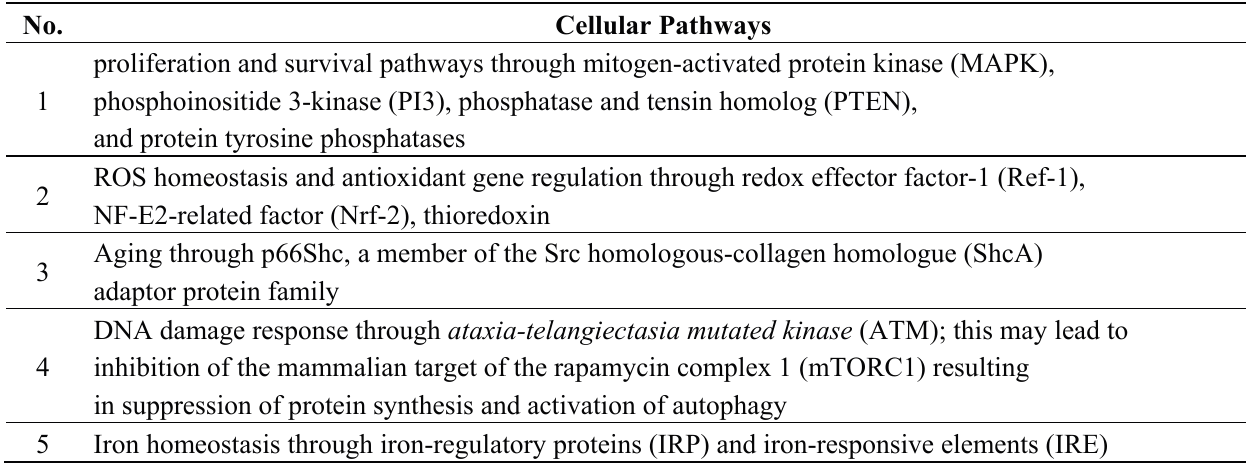
Table 1. ROS signaling is integrated into many cellular pathways